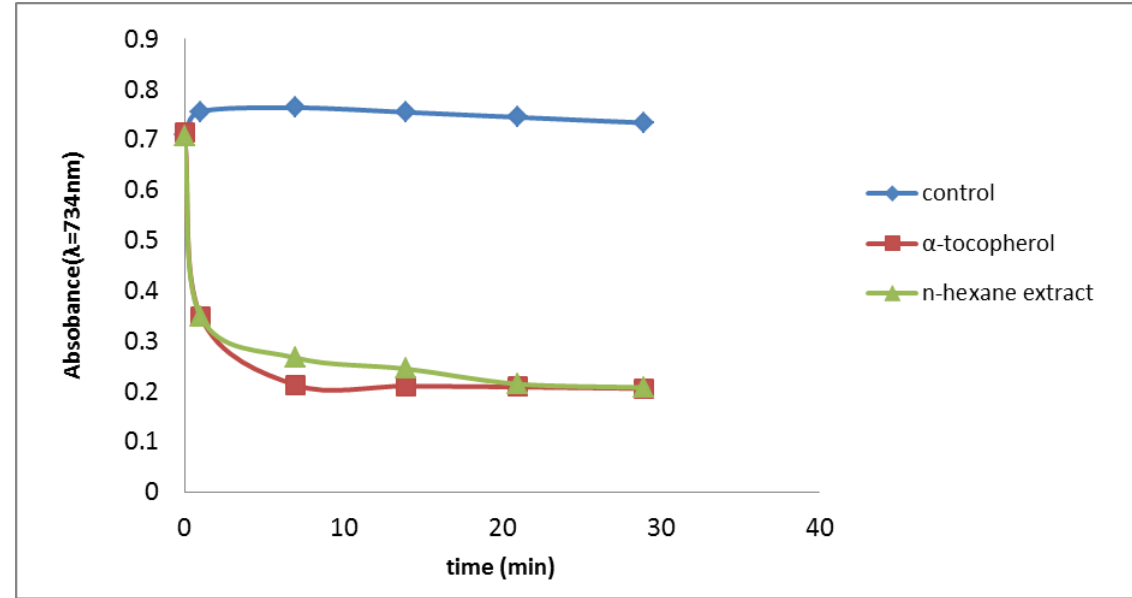
Figure 2. ABTS scavenging activity of the n -hexane extract of the leaves of P. auritum and α -tocoferol. Values are mean ± SEM and significantly p <